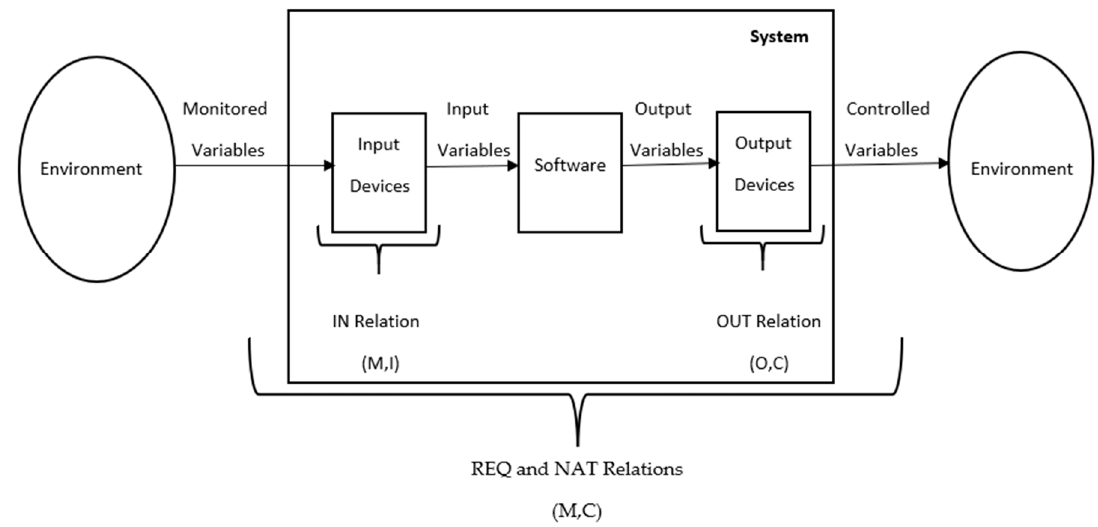
Figure 4. The quality attribute categories [25].